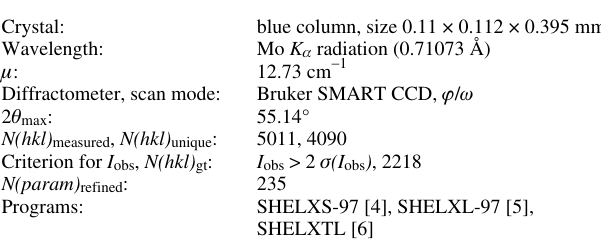
Table 1. Data collection and handling.